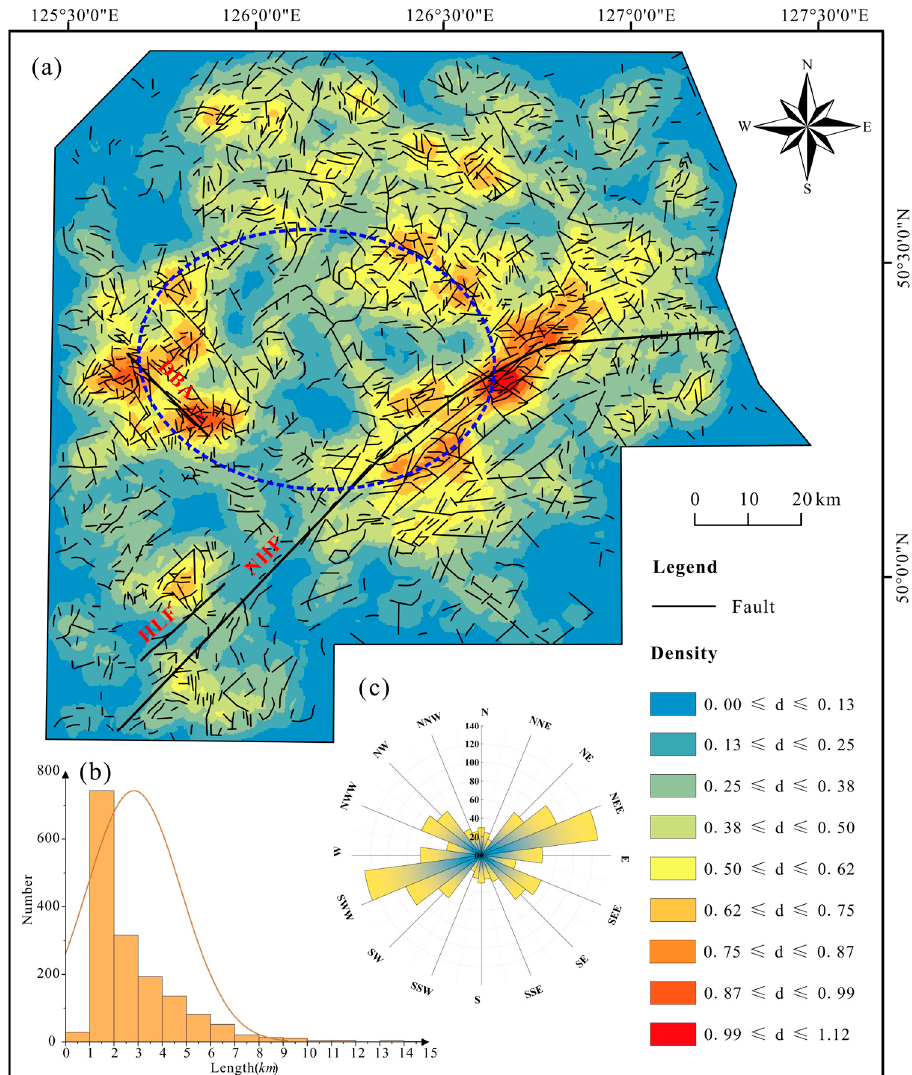
Figure 5. ( a ) Lineament density map, ( b ) Lineament length map, and ( c ) orientation distribution map of linear structure.